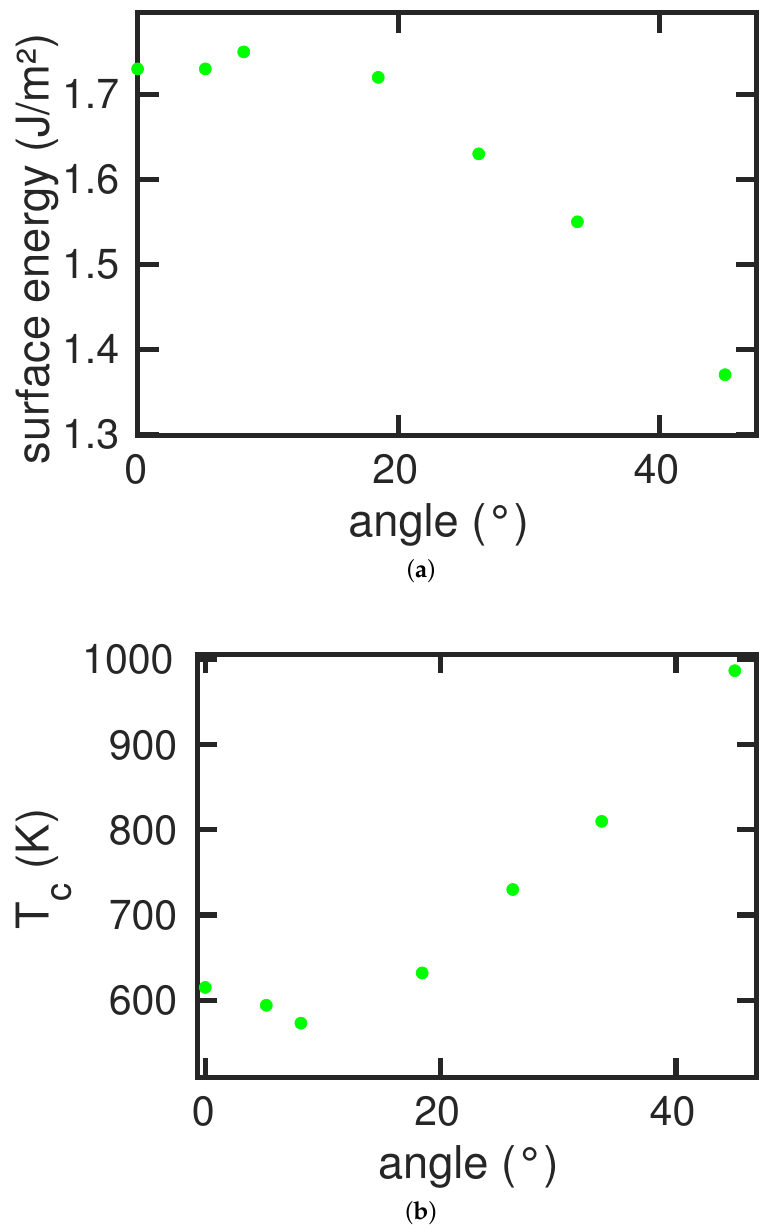
Figure 4. Dependence of the bcc specific surface energy ( a ); and the transition temperature of the austenitic phase transition T c ( b ) on the tilt angle φ